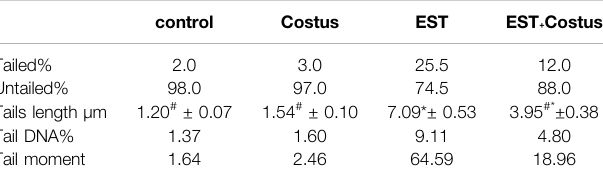
TABLE 4 | Comet assay parameters obtained by image analysis in cells of all groups after treatment